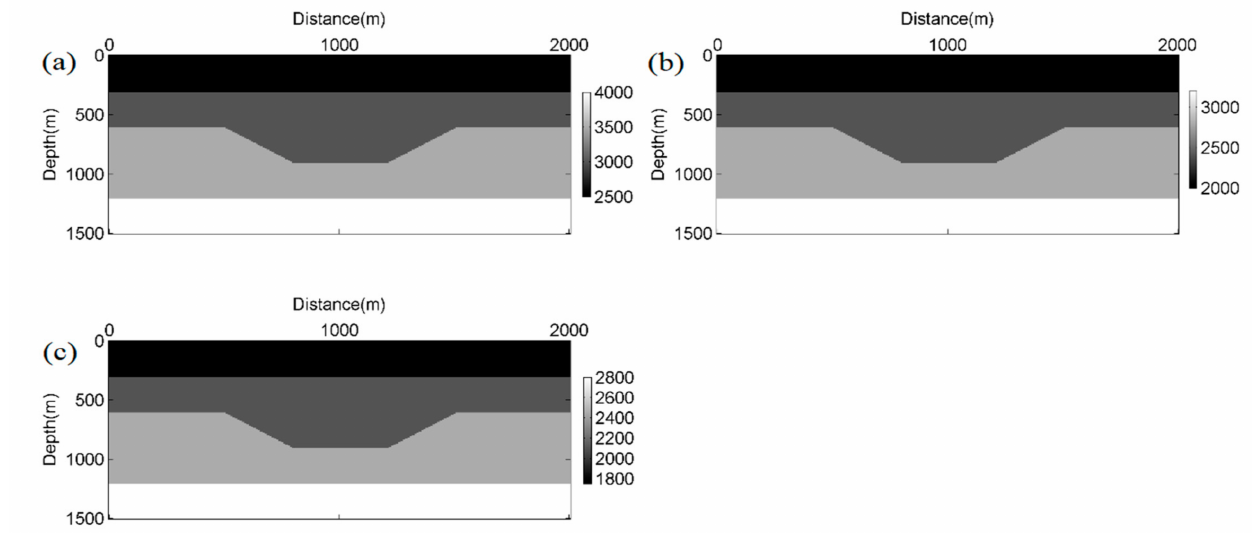
Figure 5. Graben elastic model with a horizontal topography: ( a ) V p model, ( b ) V s model, and ( c ) ρ